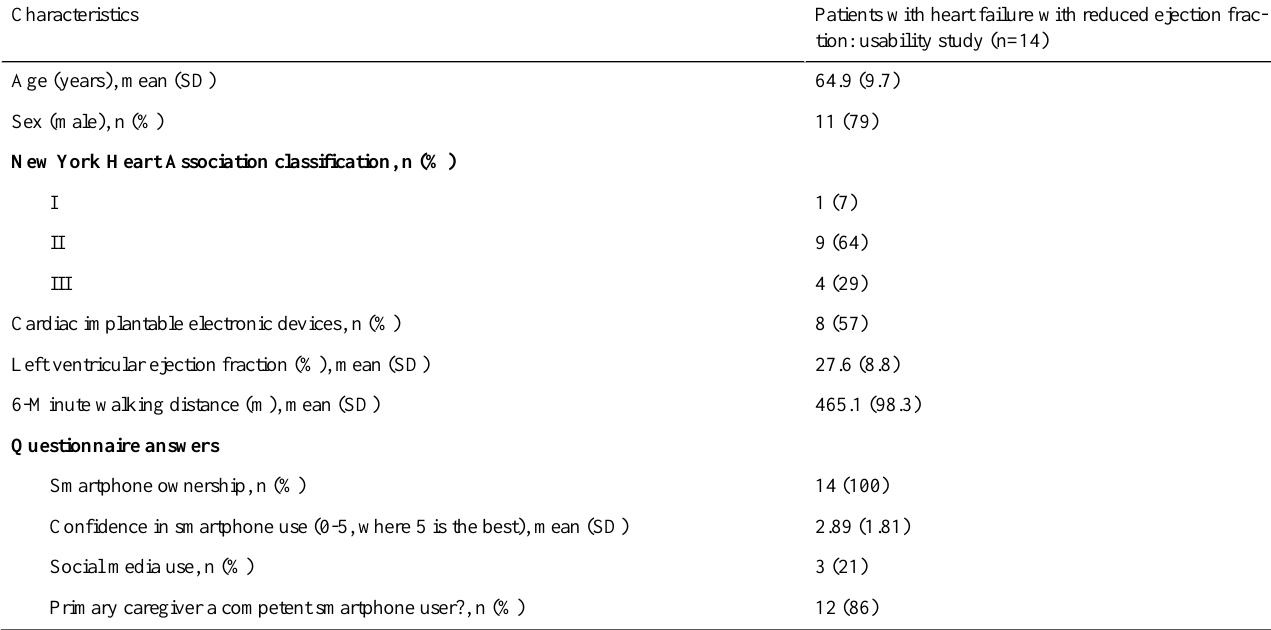
Patients with heart failure with reduced ejection frac-